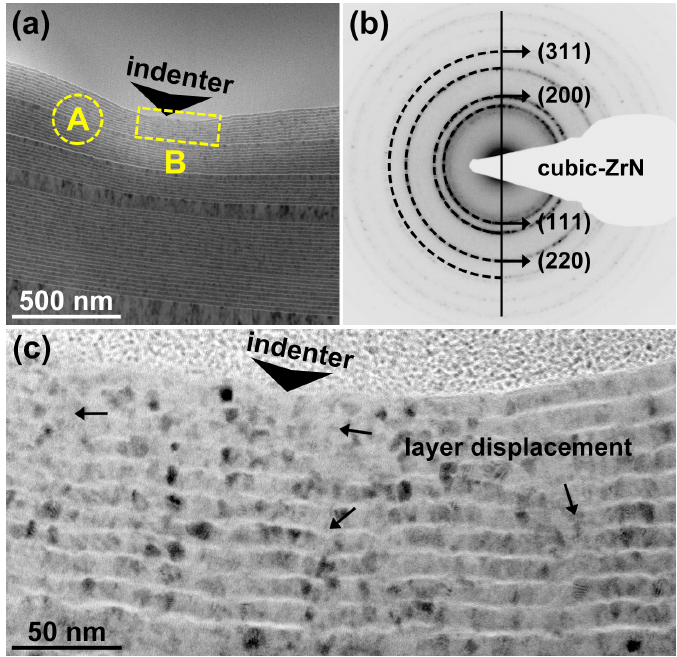
Figure 4. Cross ‐ sectional TEM images of the deformed zone just underneath the nanoindentation of the ZrN/Si 3 N 4 multilayer coating: ( a ) An overview of the indentation; ( b ) the corresponding SAED pattern of region A; and ( c ) shows a higher magnification image of framed region B.